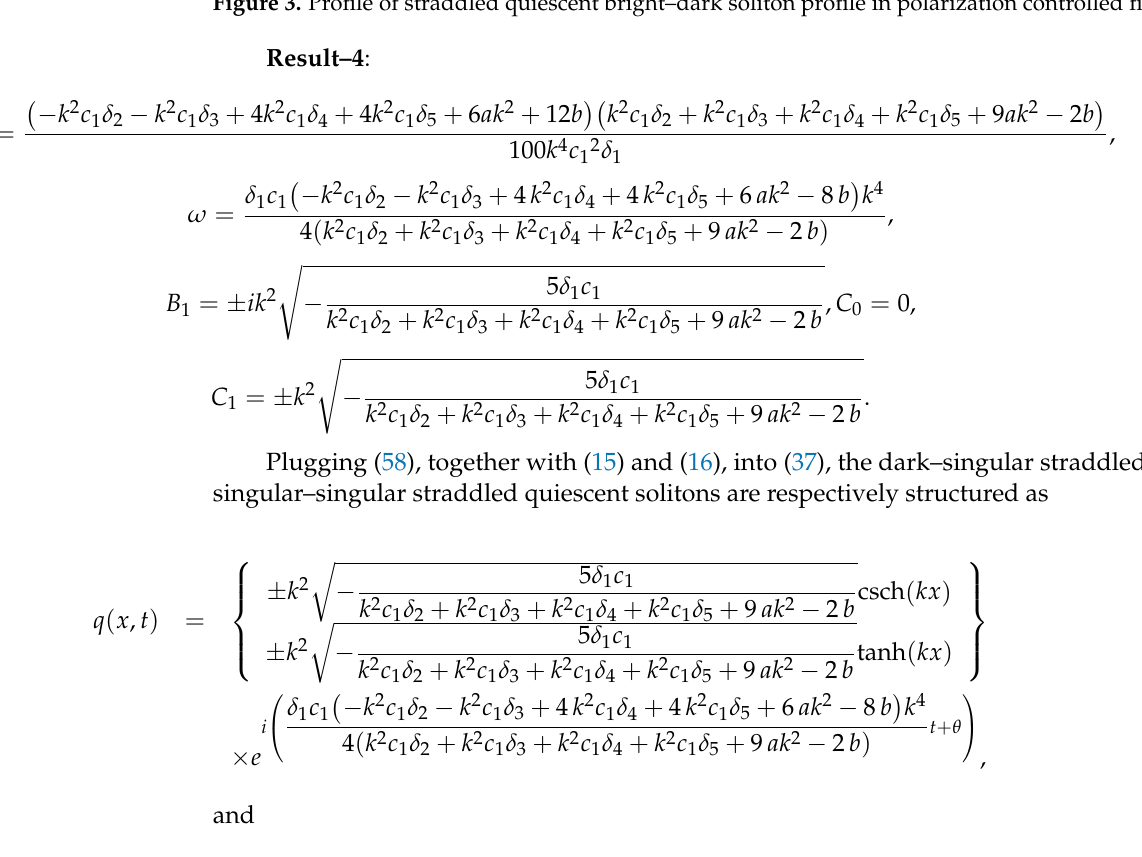
Figure 3. Profile of straddled quiescent bright–dark soliton profile in polarization controlled